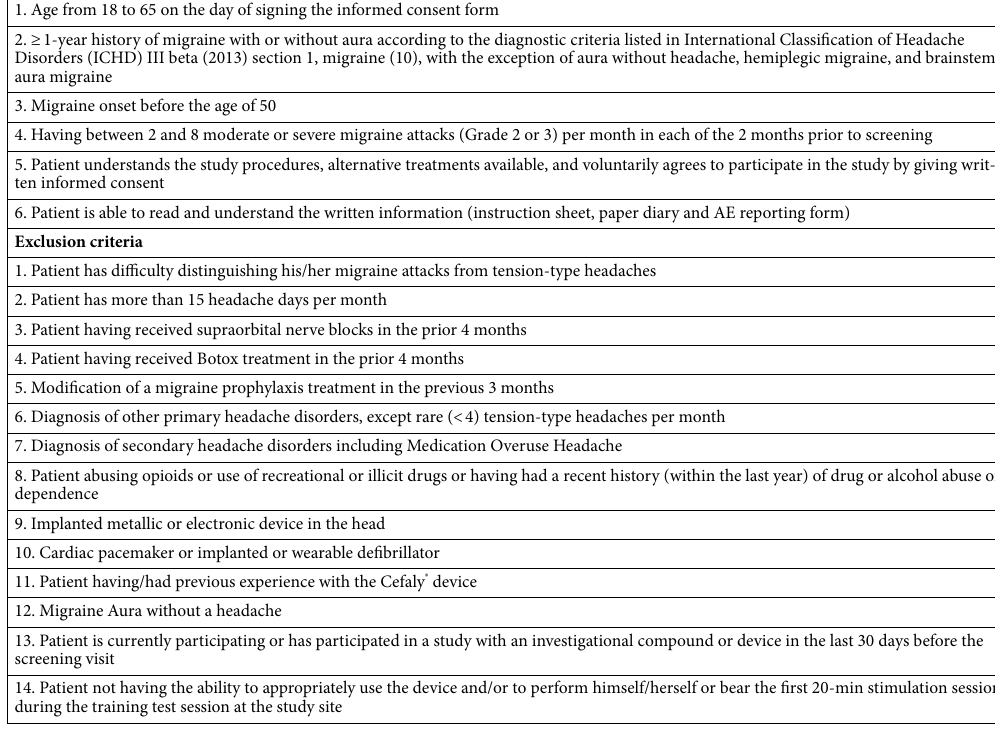
Table 1. Inclusion and exclusion criteria. ICHD-III International Classification of Headache Disorders, Third